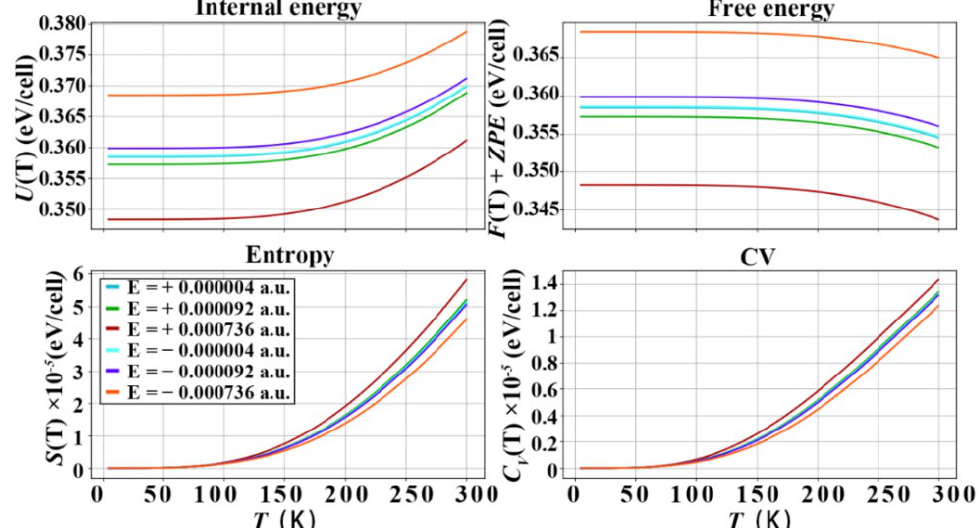
Figure 9. Thermodynamic properties of diamond, after applying different electric fields in the [001] crystallographic direction of diamond.